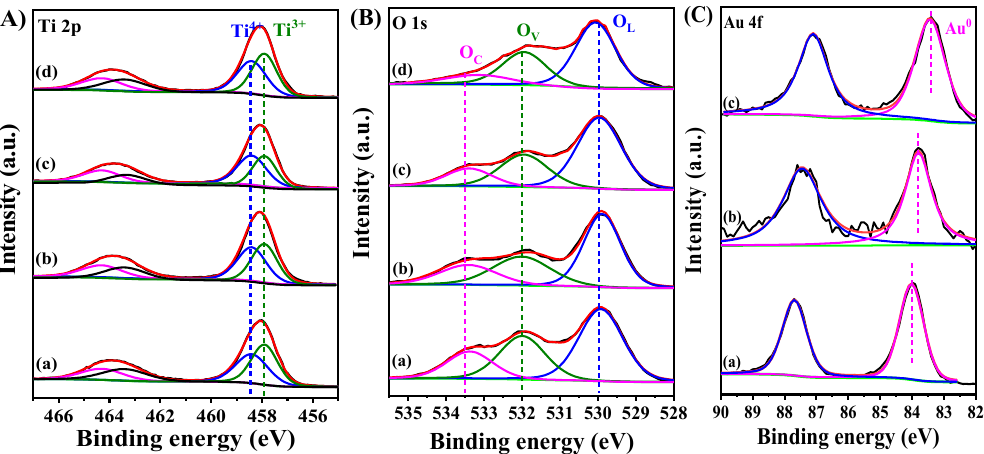
Figure 2. XPS spectra of ( A ) Ti 2p, ( B ) O 1s: ( a ) Cu 2 O / TiO 2 , ( b ) Au@TiO 2 / Cu 2 O, ( c ) Au@TiO 2 / Cu 2 O@Au, ( d ) Au@Cu 2 O / TiO 2 , and ( C ) Au 4f core level spectra: ( a ) Au@TiO 2 / Cu 2 O, ( b ) Au@TiO 2 / Cu 2 O@Au,